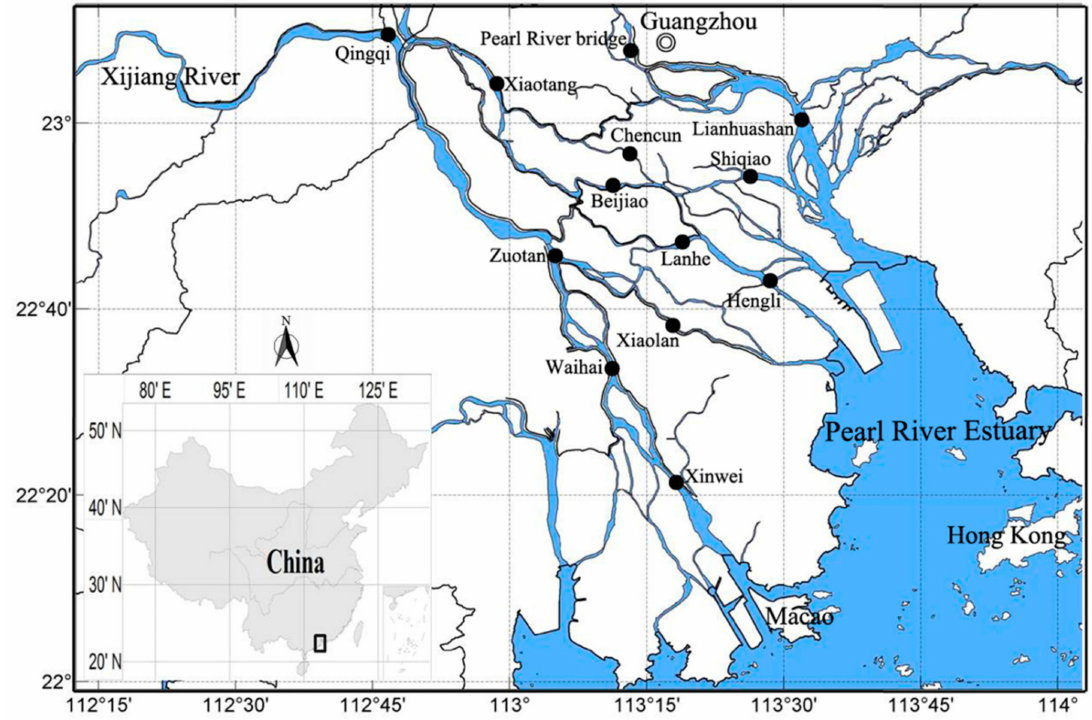
Figure 1. Map of sampling